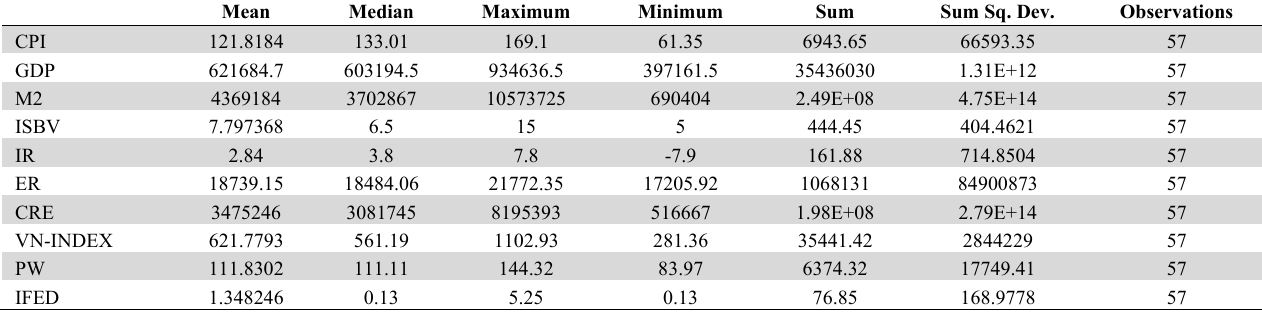
Descriptive statistics the data of variables used in the model